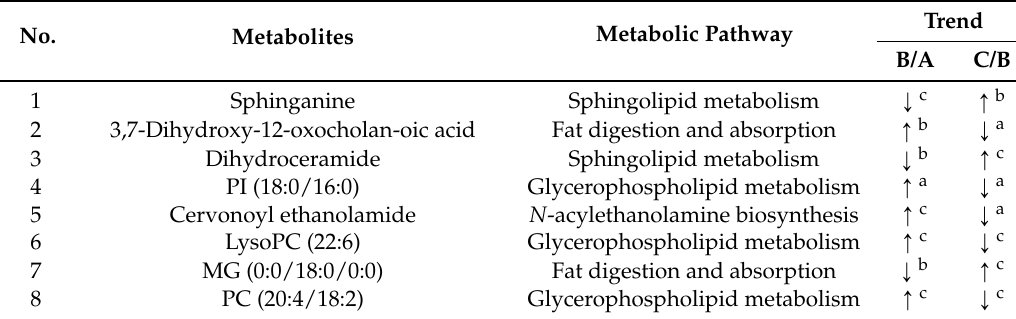
Table 3. Target biomarkers of JGG intervention.